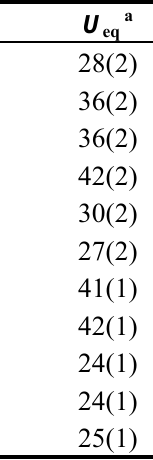
Table 2. Atomic coordinates and displacement factors U